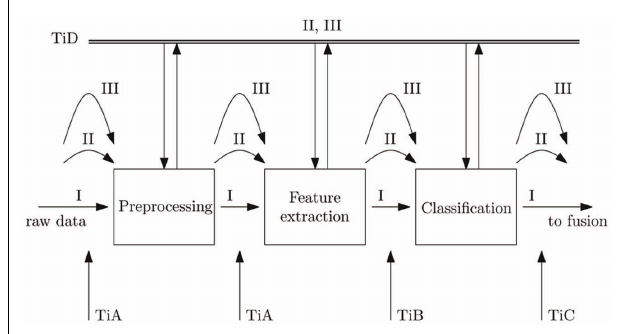
FIGURE 2 | Interfaces of the hybrid BCI with different layers. (I) Exchange of data within the same program. (II) Shared memory data exchange. (III) Network (UDP,TCP)